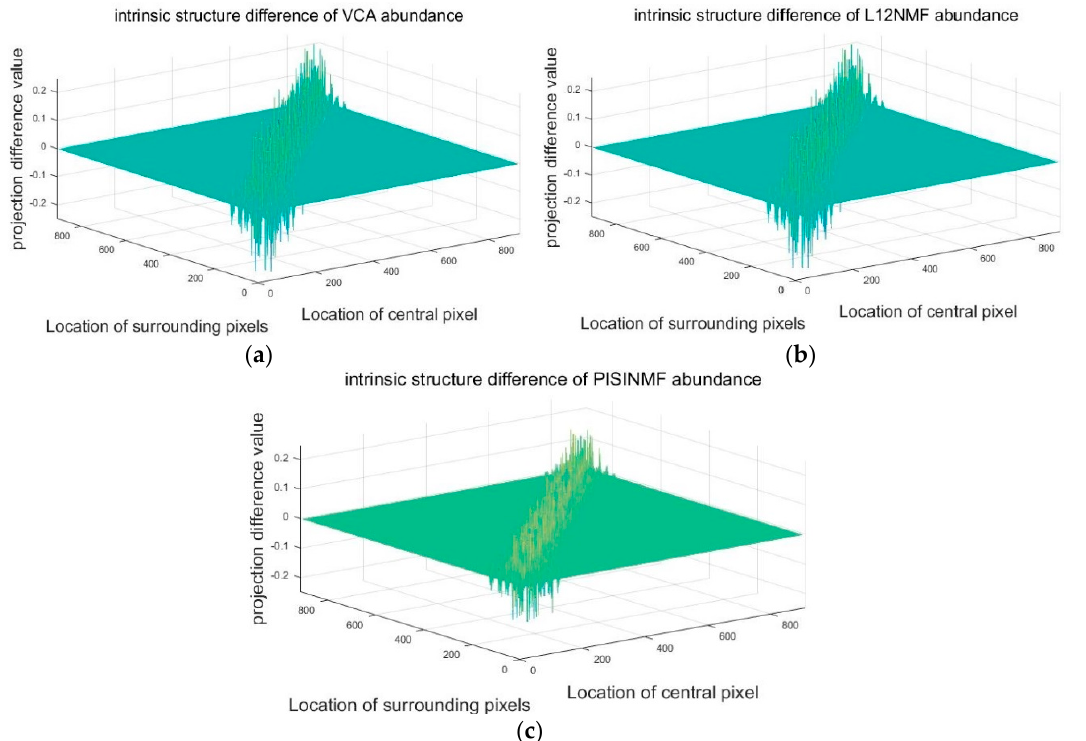
Figure 8. The difference between the intrinsic structure of the true abundance and the intrinsic structure of the estimated abundance ( a ) The difference between the intrinsic structure of the true abundance and the estimated abundance of VCA; ( b ) The difference between the intrinsic structure of the true abundance and the estimated abundance of L 12- NMF; ( c ) The difference between the intrinsic structure of the true abundance and the estimated abundance of PISINMF.